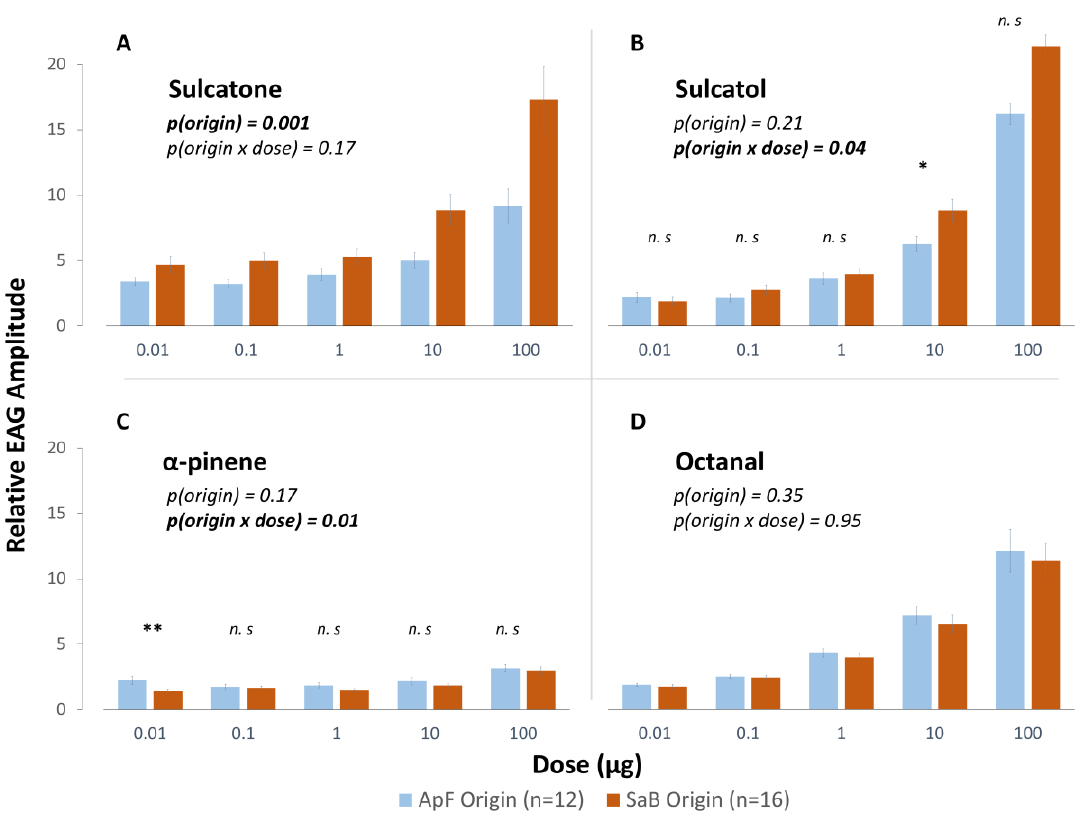
Figure 3. Mean (± SE) relative electroantennographic (EAG) amplitudes of A. ervi females reared in simple environments to volatiles emitted by the S. avenae /barley HPC (SaB): (A) Sulcatone and (B) Sulcatol; and to volatiles emitted by the A. pisum /faba bean HPC (ApF): (C) α-pinene and (D) octanal. Displayed p -values are associated to the “origin” term and to the interaction term between parasitoid origin and volatile dose in linear mixed models. Levels of significance for pairwise comparisons: n.s: Non-significant, * p < 0.05, ** p < 0.01.